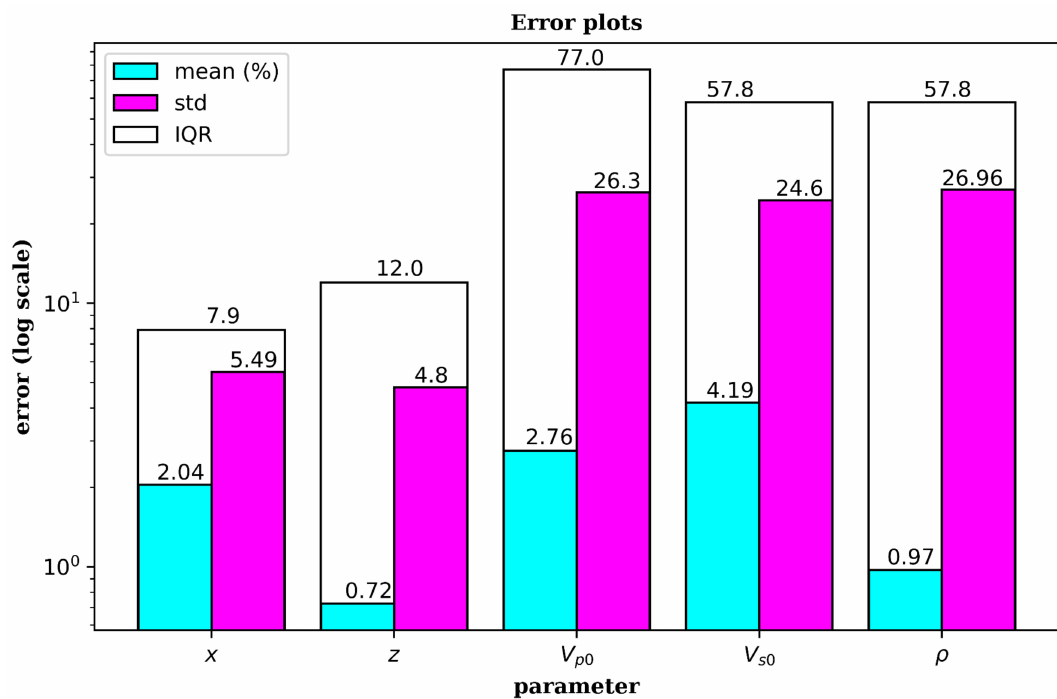
Figure 10. Error bar graph for the location and velocity model parameters inverted by deep learning. The vertical scale is logarithmic while the parameters are shown on the horizontal axis with their respective values at the top of each bar. Cyan, purple and white bars represent the mean absolute error, standard deviation and the interquartile ranges,